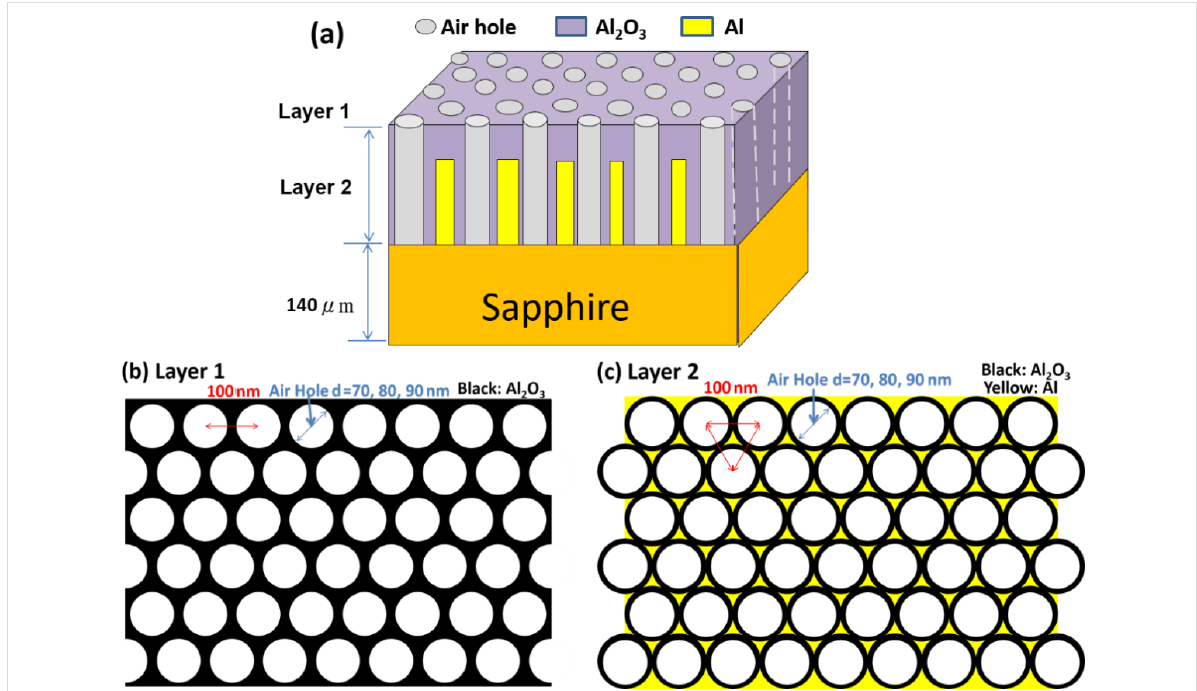
Figure 9: Sample structure used in rigorous coupled-wave analysis (RCWA) calculations: (a) AAO sample structure, (b) layer 1 structure and (c) layer 2 structure.